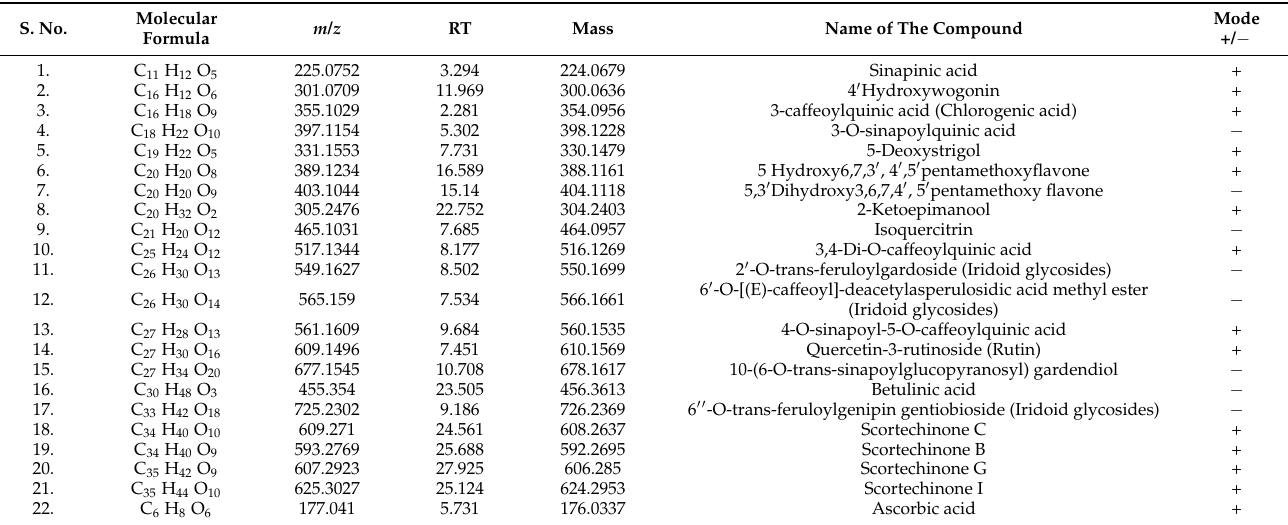
Table 1. Compounds identified in methanolic fruit extract of G. latifolia by LC-MS/MS. S.